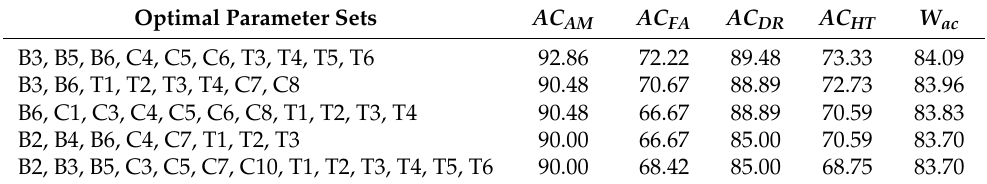
Figure 9. Importance values of employed parameters calculated from the top 200 weighted accuracies. The more frequently the parameter occurs in the first 200 parameter sets, the more important the parameter is, and the closer to 1 the importance value is. Table 7. The overall weighted accuracy ( 𝑊 𝑎𝑐 ) and classification accuracy of each species ( 𝐴𝐶 𝐴𝑀 ,𝐴𝐶 𝐹𝐴 , 𝐴𝐶 𝐷𝑅 ,𝐴𝐶 𝐻𝑇 ) achieved by optimal structural parameter sets using the best classification model.